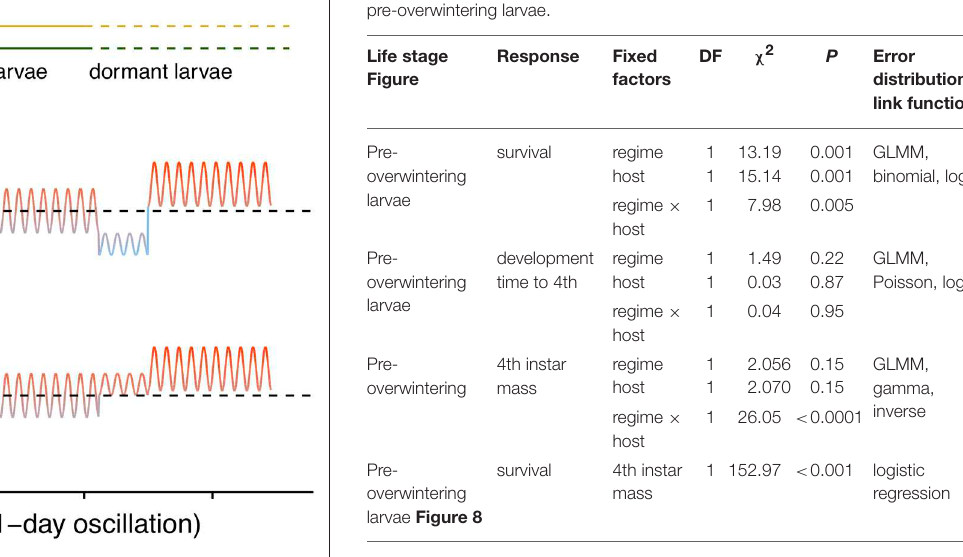
FIGURE 4 | Temperature regimes of the thermal stress and host plant assay. Lines in the top indicate the timing at which feeding (solid) and dormant (dashed) larvae experienced each regime. Dashed black lines indicate 20 ◦ C to facilitate comparison.